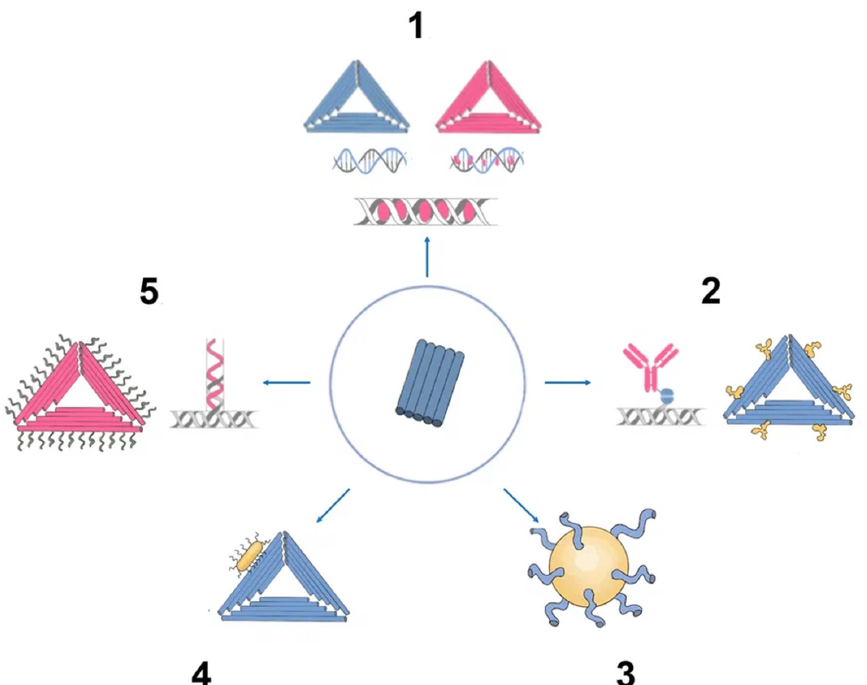
Figure 3. Origami as nanocarrier in cancer therapy. ( 1 ) Chemotherapy drugs. ( 2 ) DNA origami epitopes for IgGs. ( 3 ) DNA origami gold nanoparticle. ( 4 ) DNA origami gold nanorod nanocomplex. ( 5 ) Aptamer (e.g., MUC-1) + chemotherapy drug (e.g., doxorubicin).